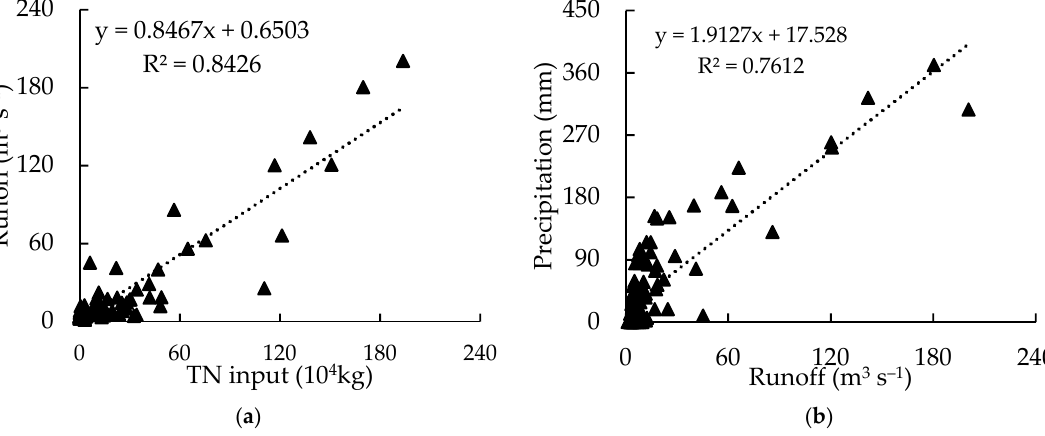
Figure 5. Relationships between runoff and TN input ( a ) and precipitation and runoff ( b ) from 2009– 2016.